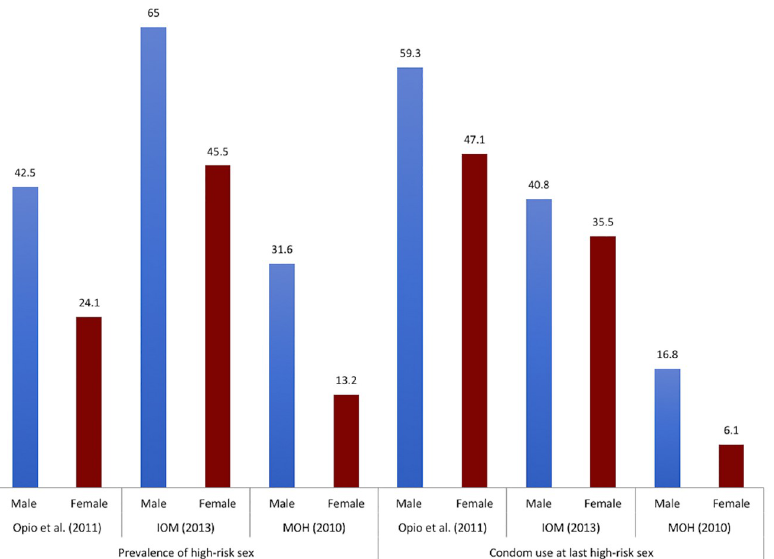
Fig 8. Prevalence of high risk sex and condom use at last high risk sex. IOM: International Organization for Migration. MOH: Ministry of Health. The numbers represent the prevalence reported as percentage (%).